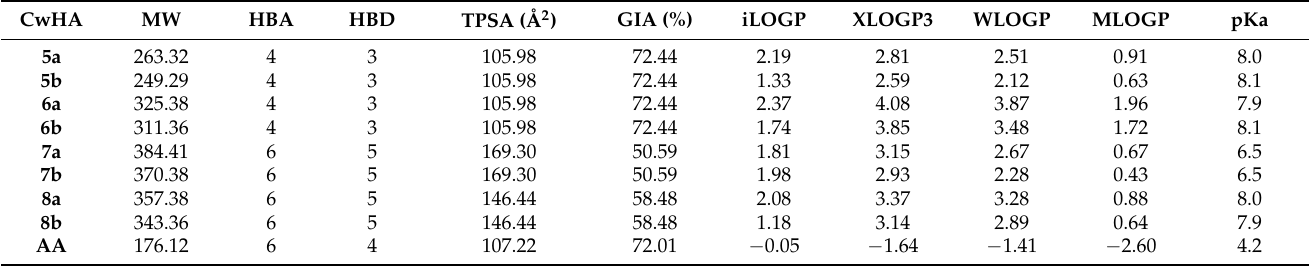
Table 12. Molecular parameters of the compounds without hydro acid (CwHA) of the final salefied compounds with strong influence on the preliminary steps of pharmacokinetics of compounds. CwHA